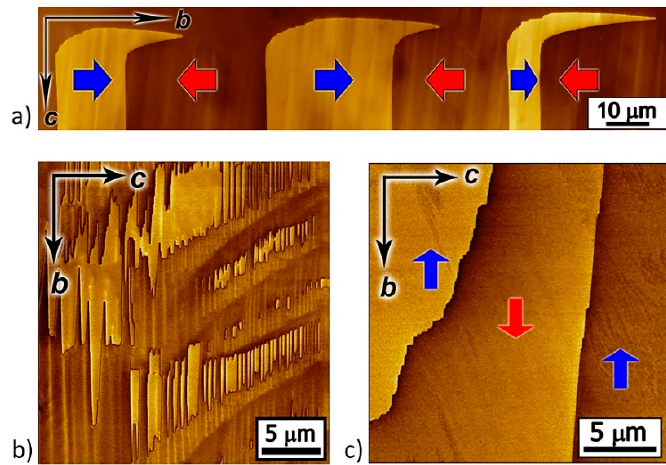
Figure 1. Piezoresponse force microscopy (PFM) images of as-grown domain structures. Lateral PFM contrast on nonpolar surfaces of β -glycine representing three types of as-grown domain structures: ( a ) Strip-like domains with flat charged domain walls, ( b ) quasiperiodic ensembles of needle-like domains, and ( c ) large domains with irregular-shaped domain walls. Red and blue arrows indicate the direction of spontaneous polarization. Arrows b and c show the directions of crystal axis.